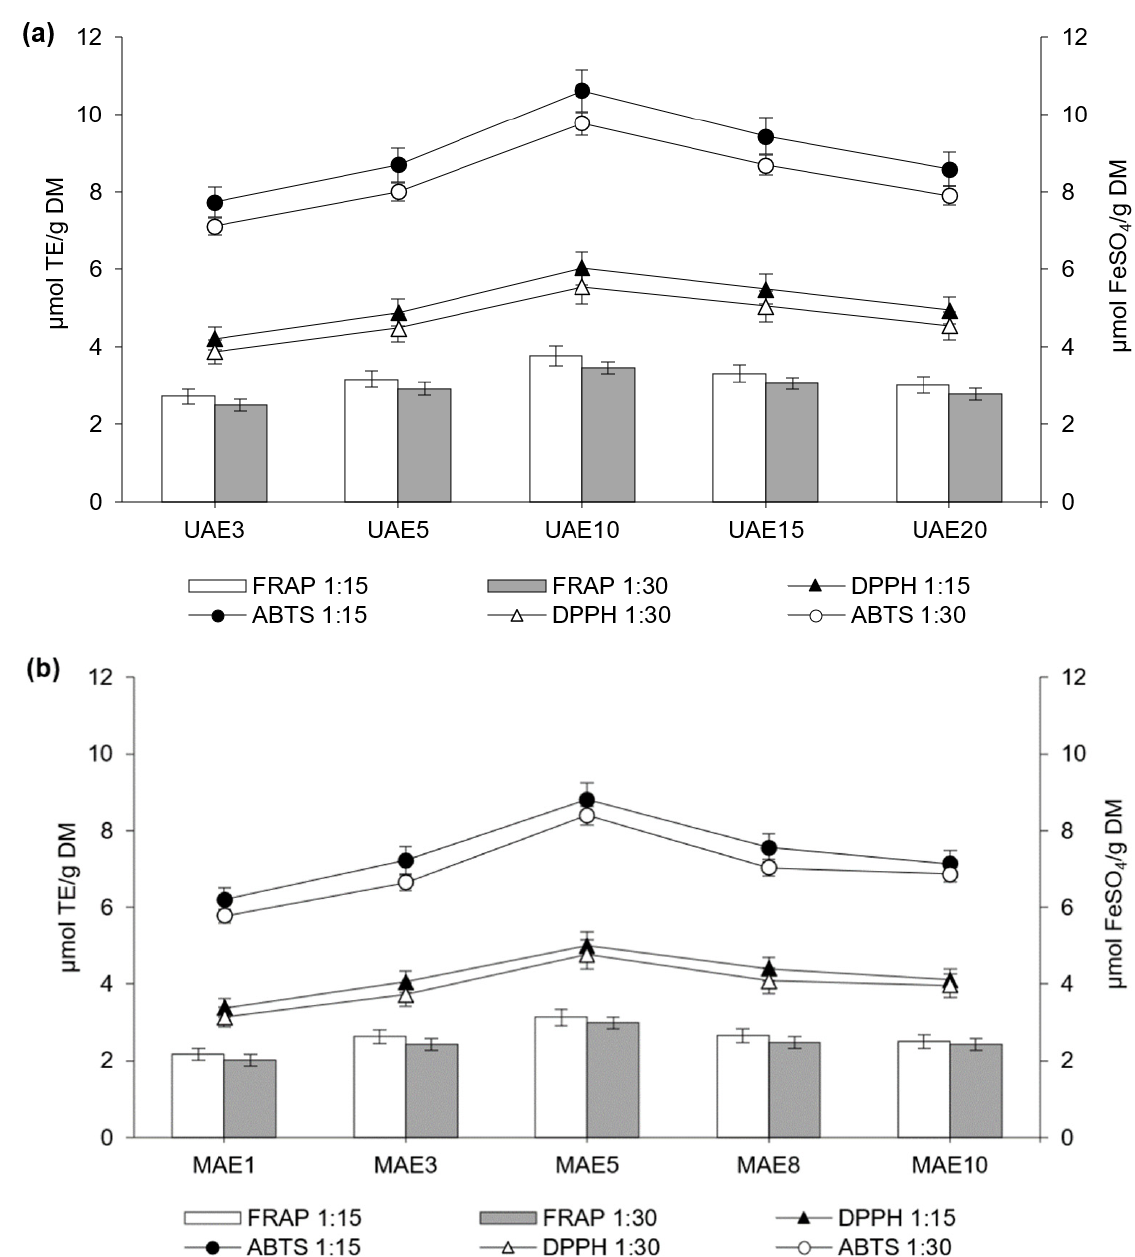
Figure 5. Antioxidant activity of the extracts from UAE ( a ) and MAE ( b ) with 60% acetone. In the abbreviations used to refer to the series, the values after UAE and MAE indicate the extraction time.